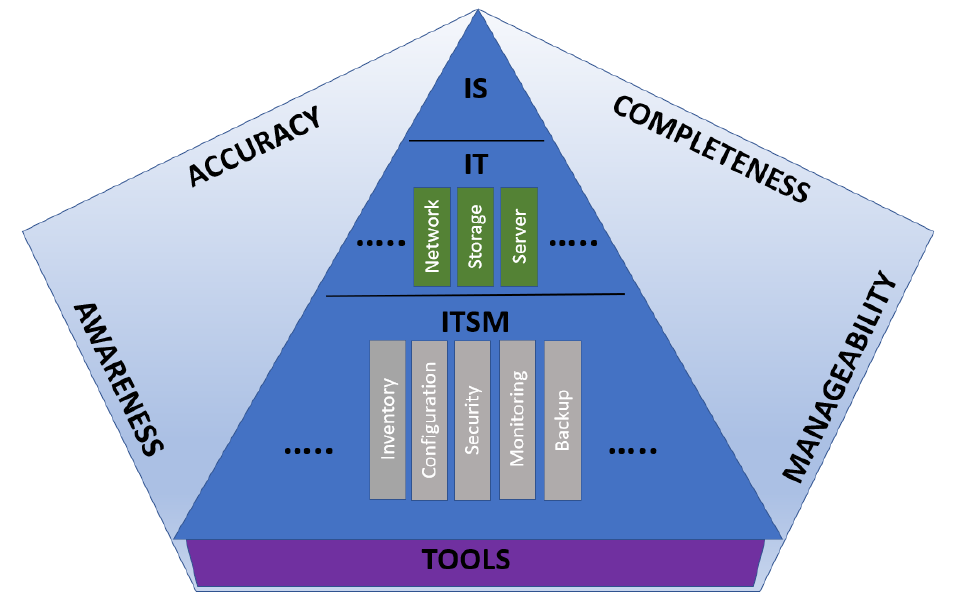
Figure 2. ITSM holistic